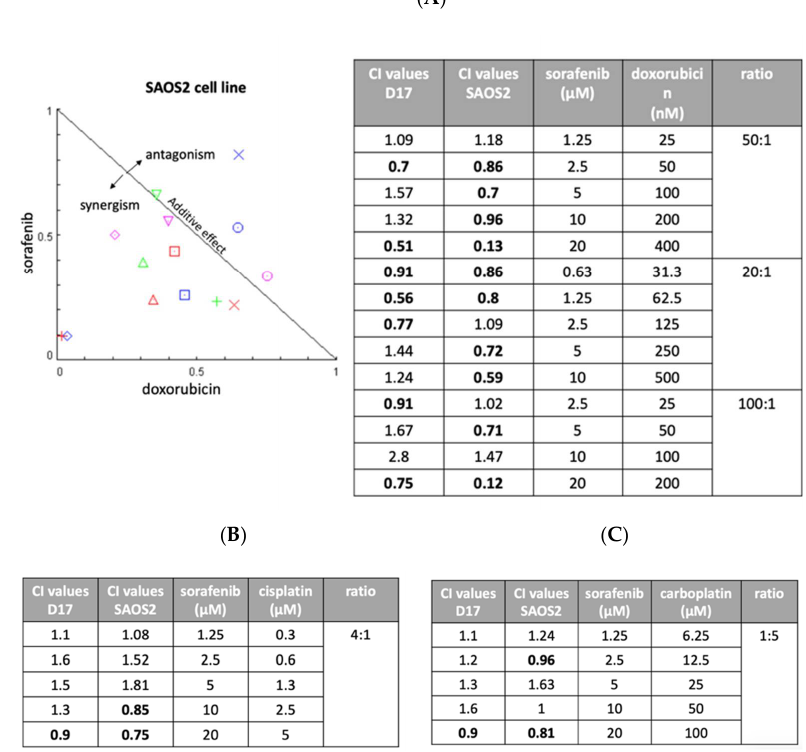
Figure 4. Three different ratios of sorafenib and doxorubicin were examined with combination index (CI) assay on SAOS2 and D17 cells. ( A ) Normalized isobologram. We included three different ratios of sorafenib and doxorubicin (20:1, 50:1, and 100:1). ( B ) The combination of sorafenib and cisplatin was examined on D17 and SAOS2 cells at a ratio of 4:1. ( C ) The combination of sorafenib and car- boplatin was examined on D17 and SAOS2 cells at a ratio of